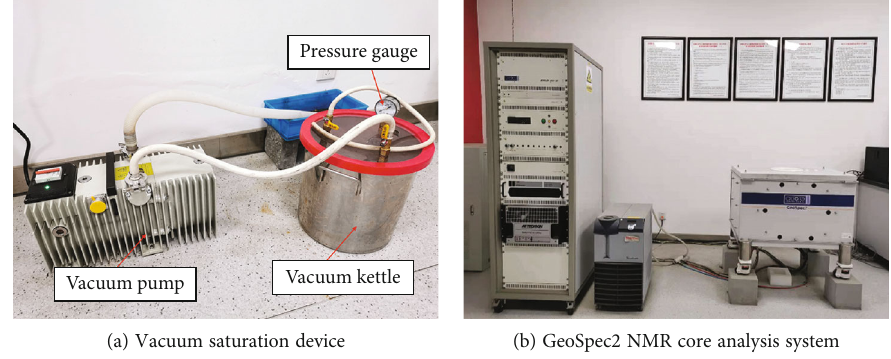
Figure 9: Instruments for measuring porosity by NMR. Table 4: Porosity measured by the NMR method.